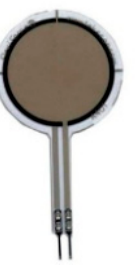
Figure 8. IMS-C20A thin-film pressure sensor. Different block masses were used to apply continuous vertical loads to the sensor, and a voltage-resistance conversion module was used to convert the resistance into voltage. The data were read and recorded by a dynamic signal analyzer (Figure 9).